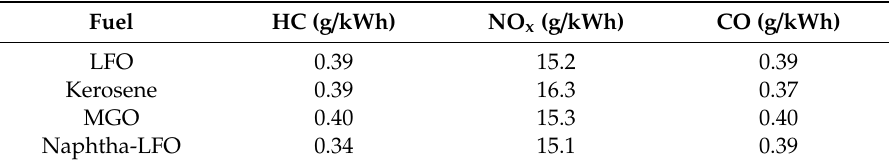
Table 5. Brake specific emissions of hydrocarbons (HC), nitrogen oxides (NO x ), and carbon monoxide (CO) at full load with different fuels.